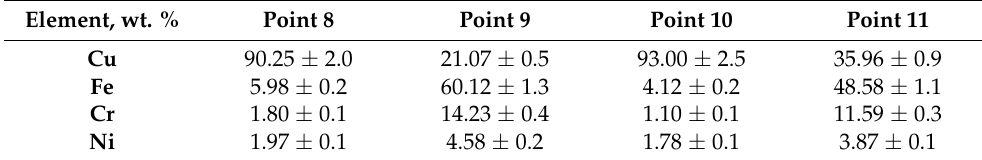
Figure 5. SEM results of the sample welded with a beam power of 3600 W (Sample 3): ( a ) SEM image of the obtained joint, ( b ) higher-magnification SEM image of the fusion zone (FZ) near SS, ( c ) higher-magnification SEM image of the fusion zone (FZ) near copper, and (d) distribution of the elements across the welded joint studied by EDX. Table 3. Chemical composition of each point marked on SEM images of Sample 3.